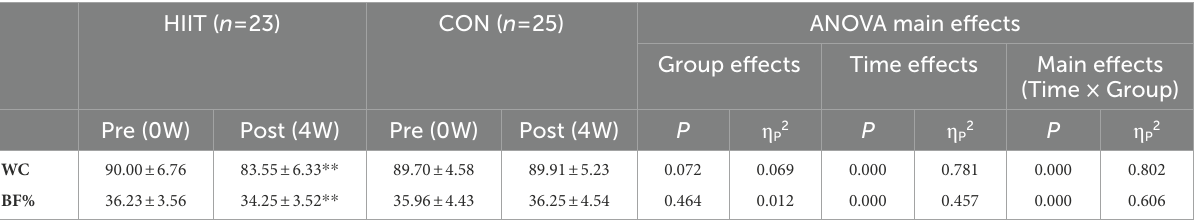
TABLE 3 Body composition of the two groups before and after the four-week study program.